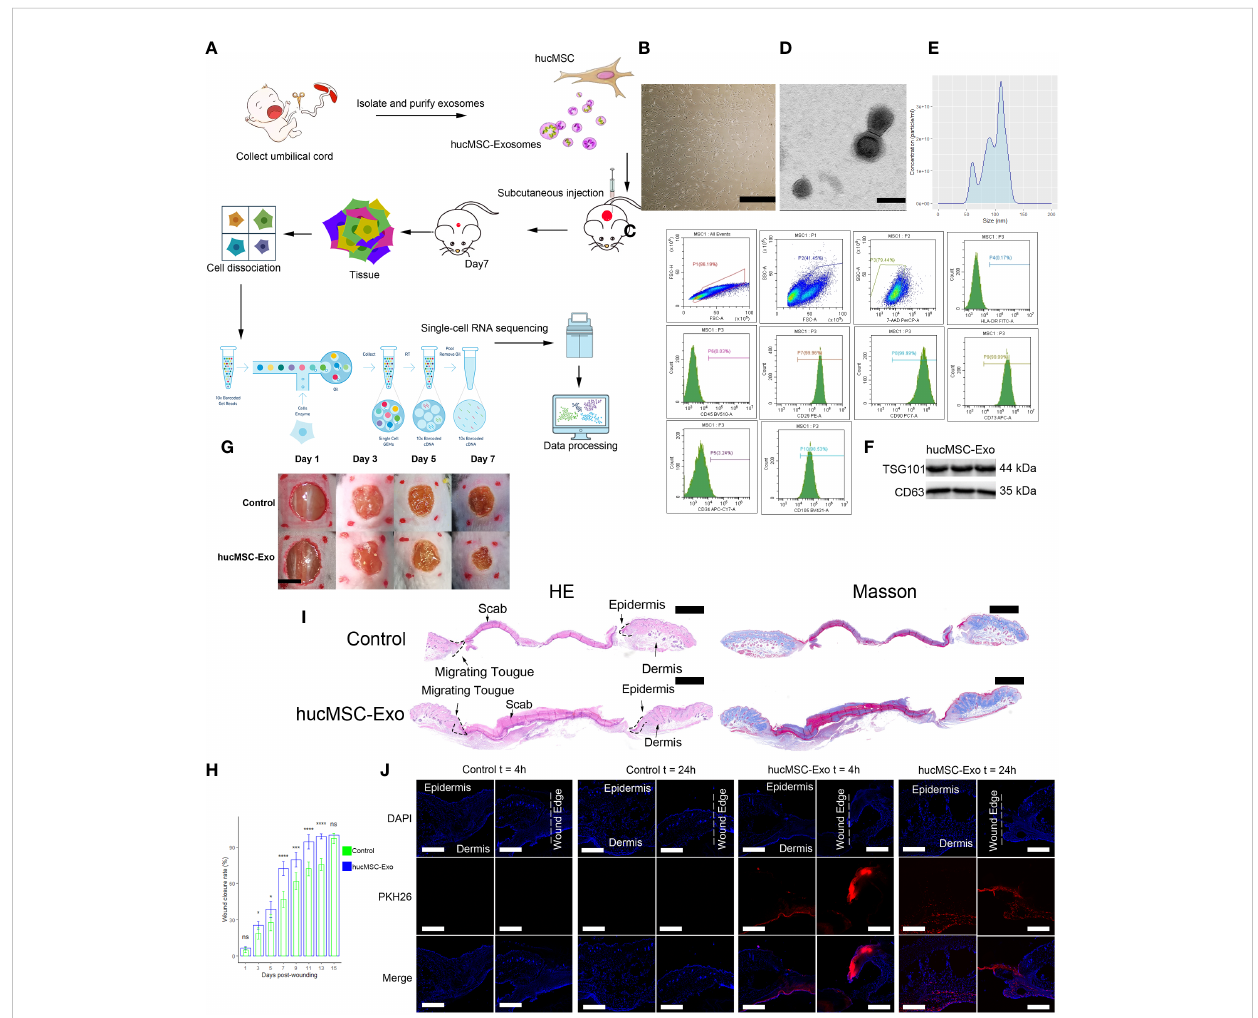
FIGURE 1 HucMSC-Exosomes accelerate wound healing. (A) Schematic overview of the study design. (B) Microscope image of huc-MSCs. The scale bar is 500 µm. (C) Flow cytometry analysis of HLA, CD29, CD34, CD45, CD73, CD90 and CD105 expression on the huc-MSC surface. (D) Transmission electron microscopy image of hucMSC-Exosomes. Scale bar, 100 nm. (E) Density plot of hucMSC-Exosomes. (F) Western blot of hucMSC-Exosome markers (G) Representative images of wound closure process of hucMSC-Exosomes treatment and PBS control. The scale bar is 4 mm. (H) Wound closure rate of hucMSC-Exosomes treatment and PBS control group. Two-tailed unpaired t-test (n=6). Error bar: mean standard deviation. ns, not signi fi cant, *p < 0.05, ***p < 0.001, ****p < 0.0001. (I) H & E and Masson staining of wounds seven days after injury. Scale bar = 1mm. (J) Uptake of hucMSC-Exosome by skin wound in vivo . Scale bar, 500 m